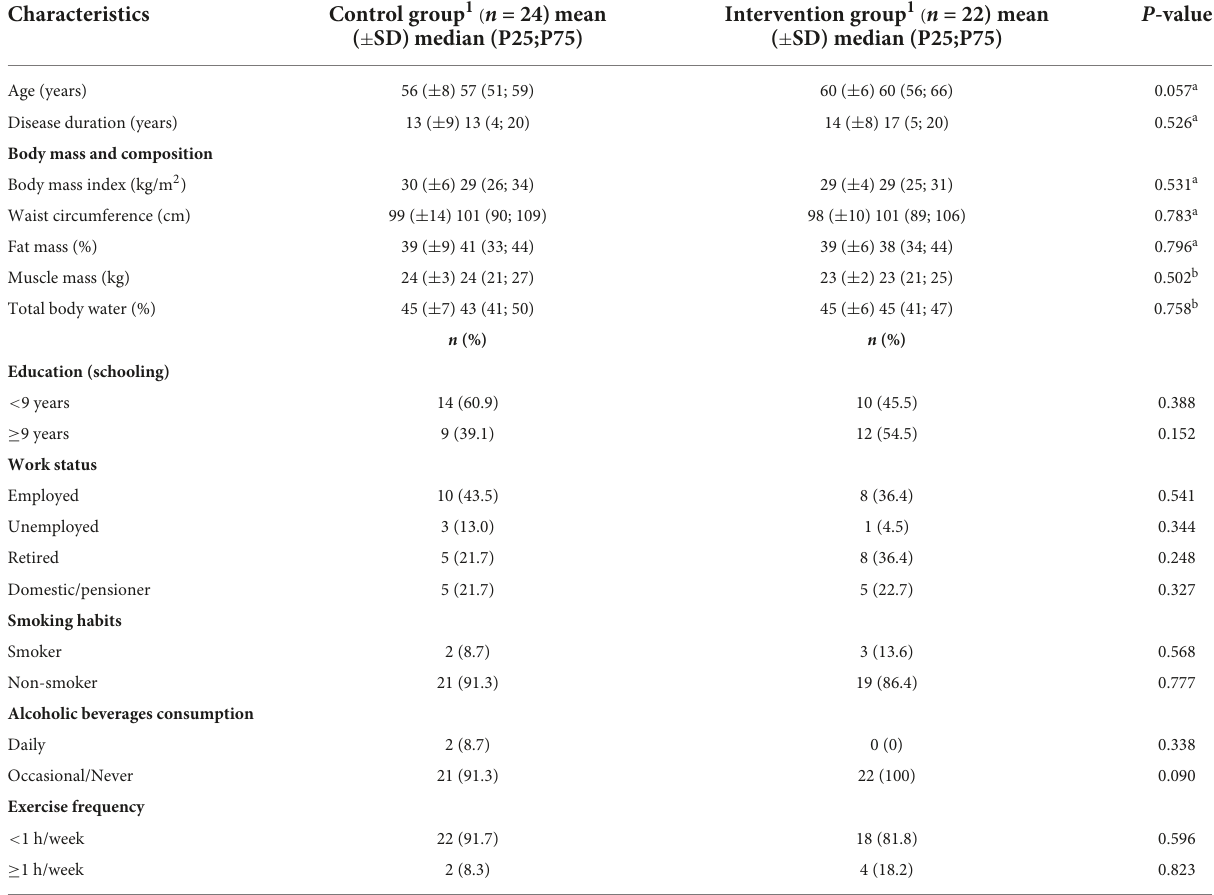
TABLE 1 Baseline socio-demographic and lifestyle characteristics of the participants.